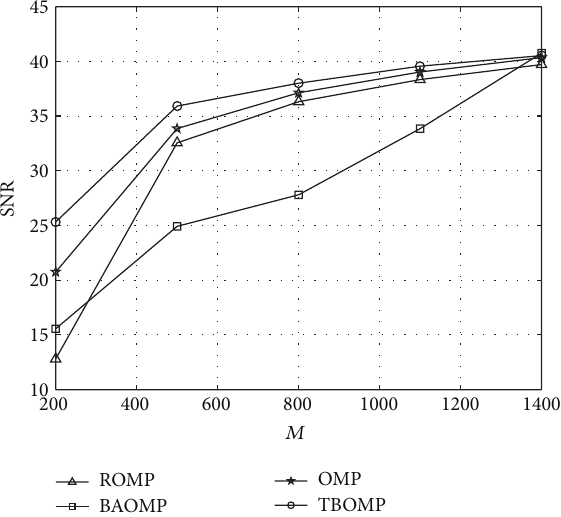
Figure 7: SNR comparison for different values of 𝑀